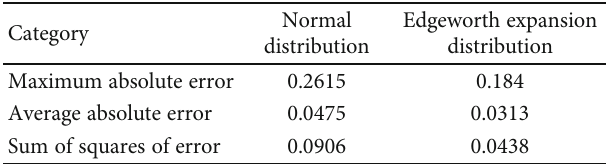
Table 2: Error analysis of travel time estimation in late peak